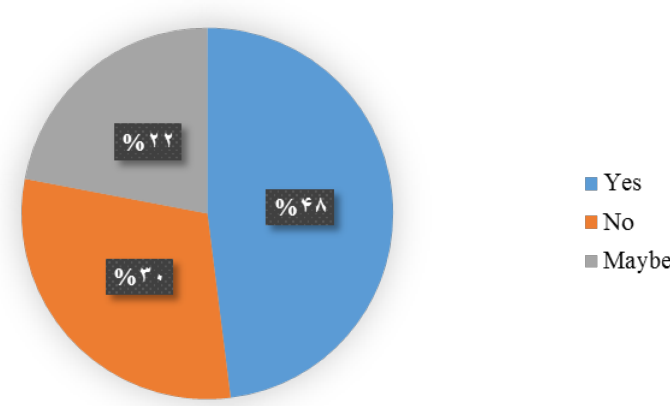
Figure - 10: Showing online learning course is a better way for the future of Indian education